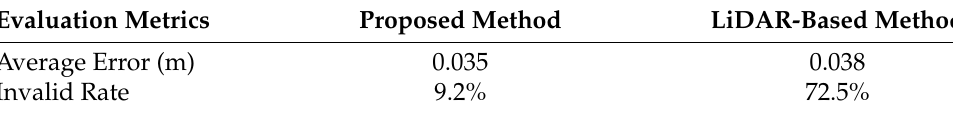
Table 3. Average error and invalid rate of the testing route with intermittent straight curbs.